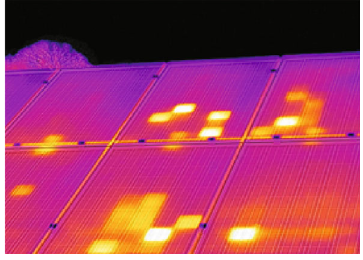
Figure 6: Thermal image of PV